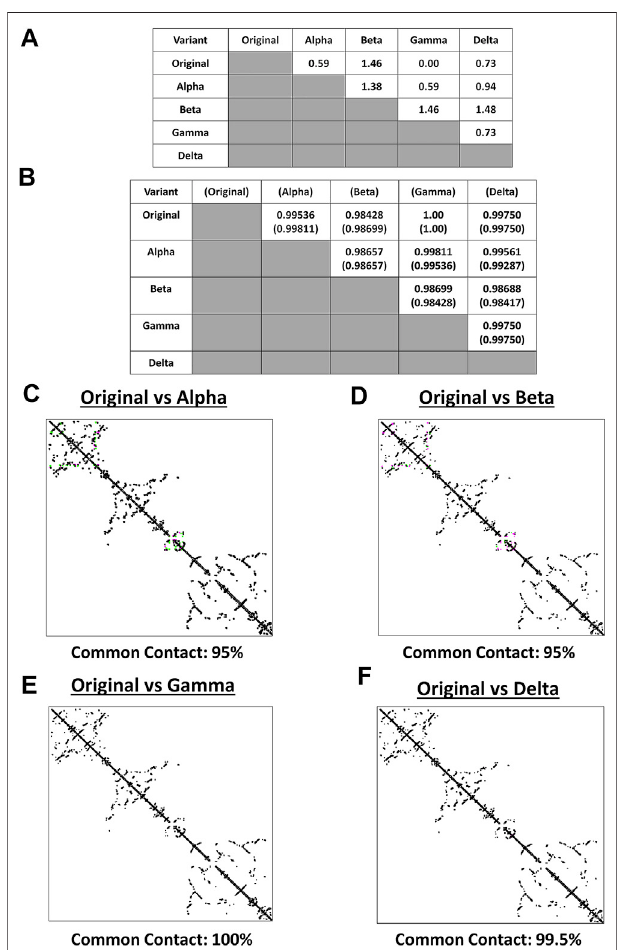
FIGURE2| Structural comparison ofthe originalSARS2 and VOC spike models based on the whole protein. (A) RMSD values and (B) TM scores of superimposed spike models are tabulated. TM scores normalized to a spike model are distinguished by the presence or absence of a parenthesis. Contact maps of the (C) original SARS2 and alpha variant (D) original SARS2 and beta variant (E) original SARS2 and gamma variant, and (F) original SARS2 and delta variant are shown. Common contact of the protein structures being compared are labeled below. Contacts present in both protein structures (black) and present in one of the protein structures [either pink( fi rstproteinstructureuploaded:originalSARS2)orgreen(secondprotein structure uploaded: VOC)] are